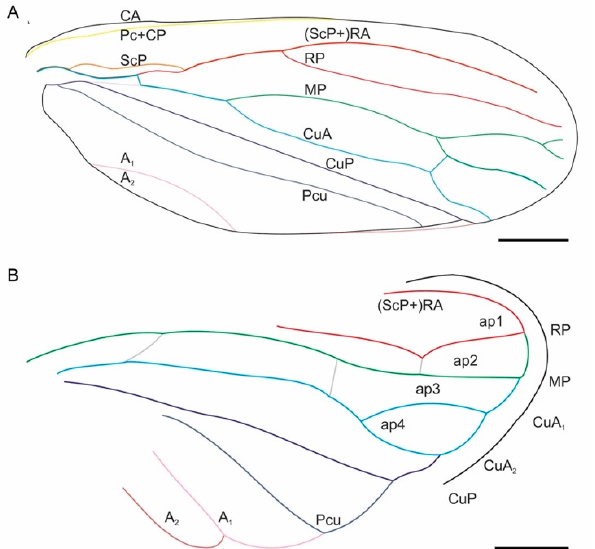
Figure 4. Line drawings of wing venation of Nangamostethos tibetense gen. et sp. nov. ( A ) Line drawing of the tegmen of XDA2-0430A. ( B ) Interpretive drawing of the hind wing based on XDB3-1209. A 1 , first anal vein; A 2 , second anal vein; ap1, interradial apical cell; ap2, radial cell; ap3, medial cell; ap4, cubital cell; CA, costa anterior; CP, costa posterior; CuA, cubital anterior; CuP, cubitus posterior; MP, media posterior; Pc, precosta; Pcu, postcubitus; RA, radius anterior; RP, radius posterior; ScP, subcosta posterior. Scale bars: 1 mm.